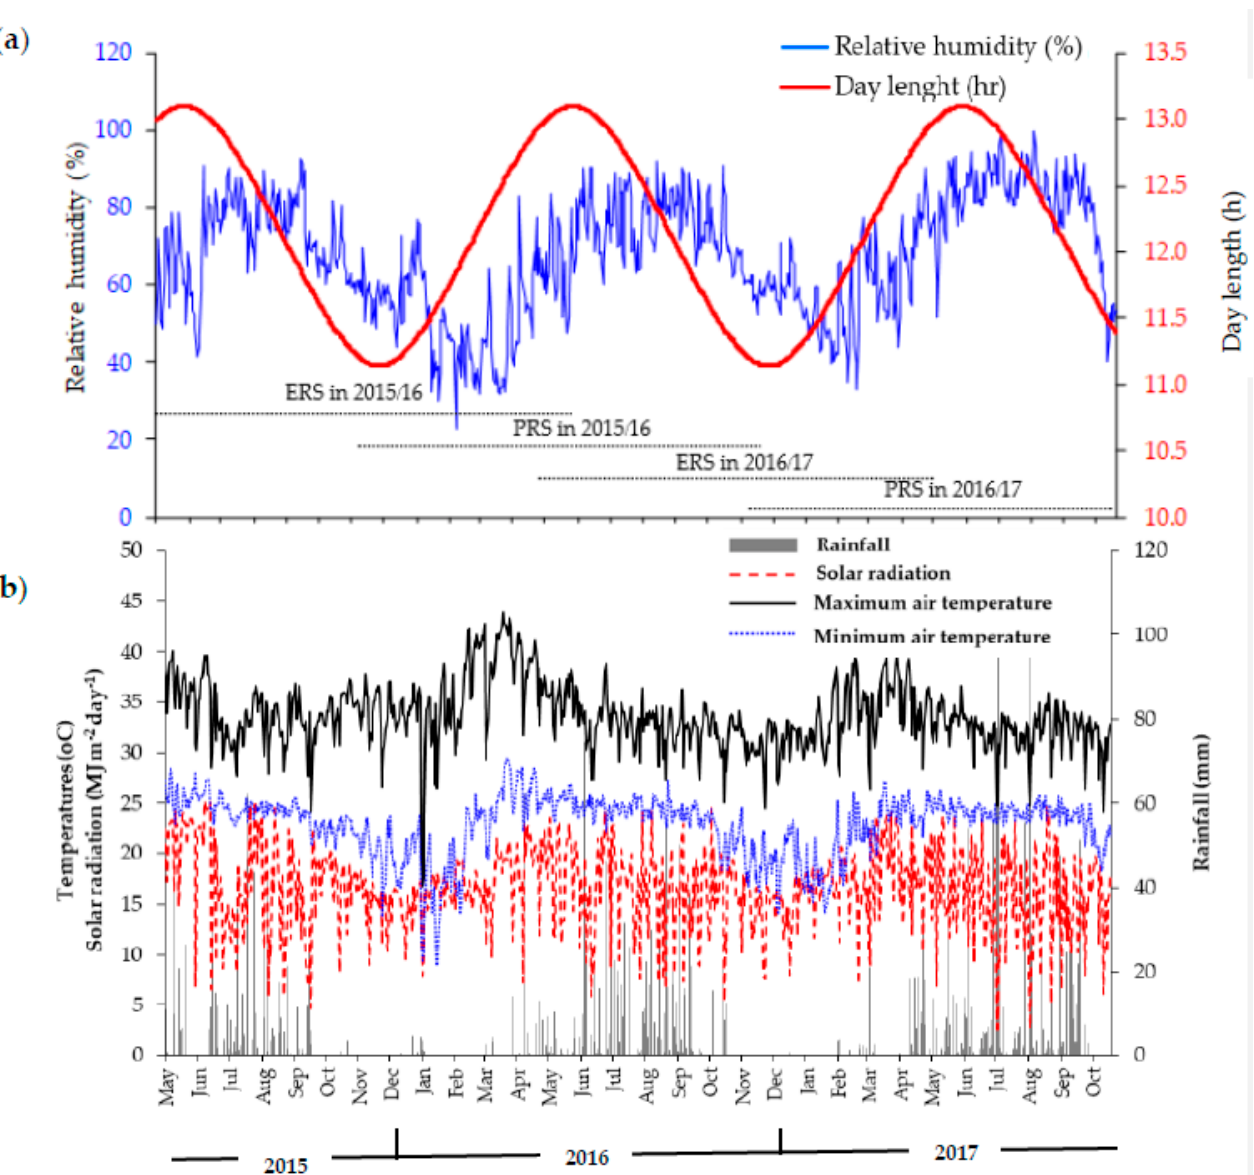
Figure 1. Relative air humidity (%), day length (h) ( a ) rainfall (mm), solar radiation (MJ m − 2 day − 1 ), maximum and minimum air temperatures (°C) ( b ) during the crop growth period of cassava. ERS = early rainy season, PRS = post rainy season.